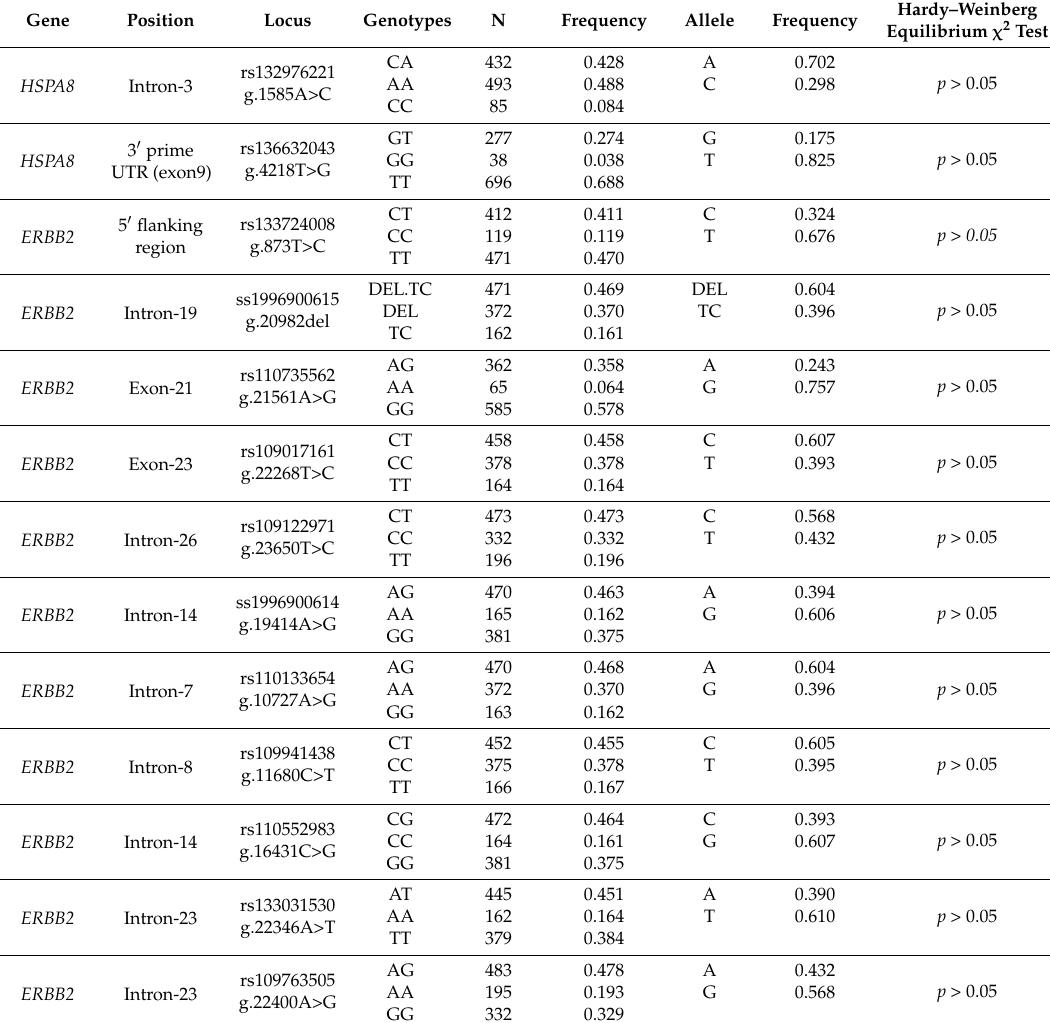
Table 2. Genotypic and allelic frequencies and Hardy–Weinberg equilibrium test of SNPs of HSPA8 and ERBB2 genes in Chinese Holstein